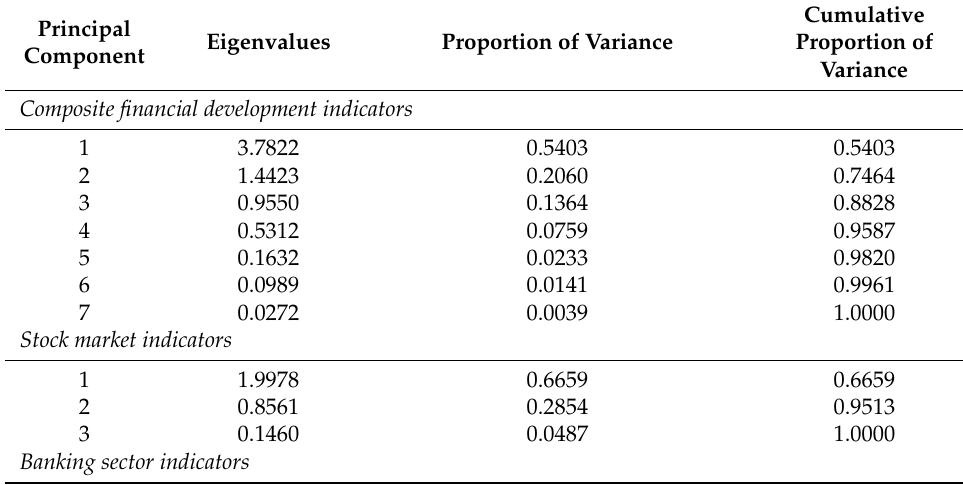
Table 1. Principal component analysis of financial development